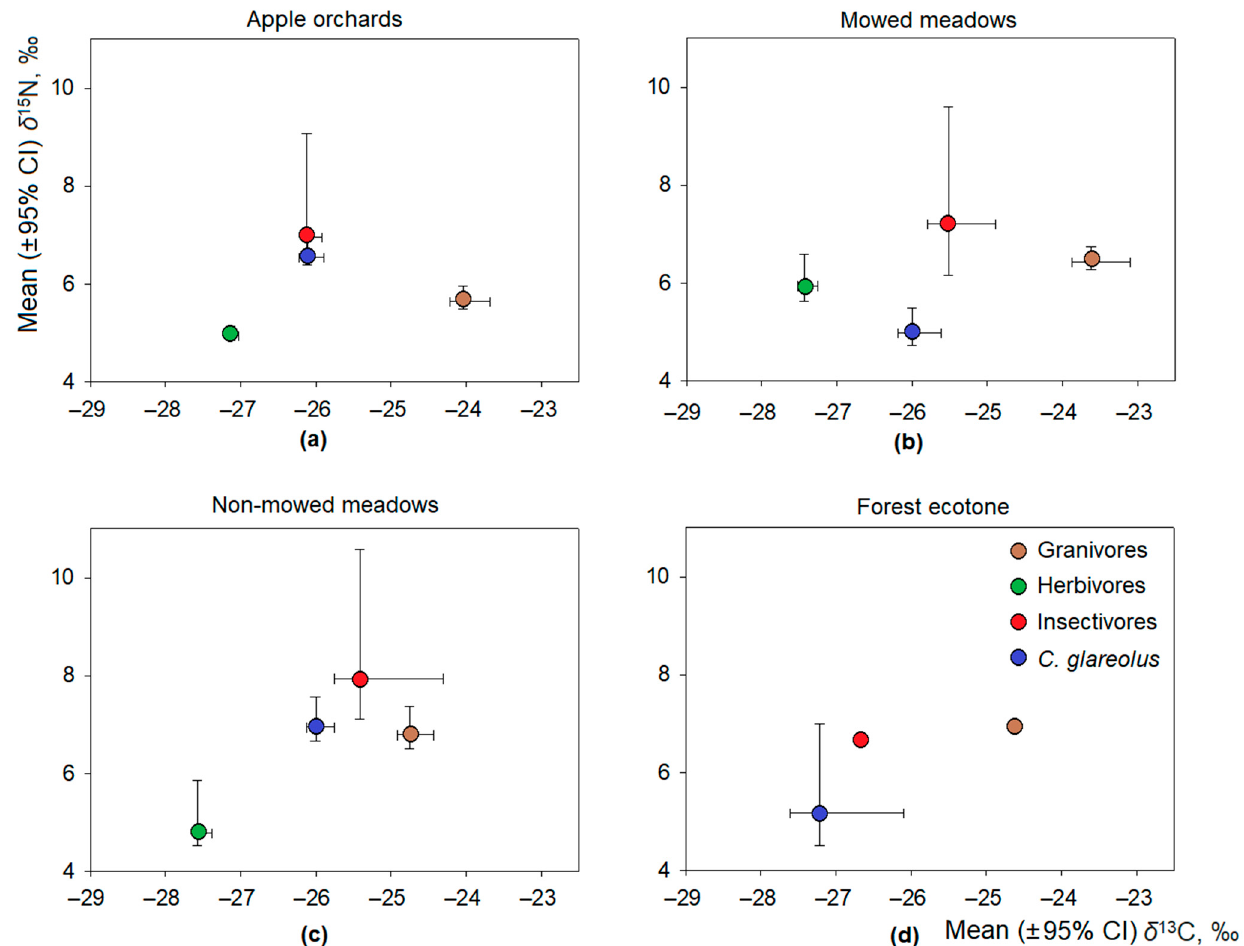
Figure 3. Position of C. glareolus and species of the other trophic groups according to stable isotope ratios: ( a ) in the apple orchards; ( b ) in mowed meadows; ( c ) in non-mowed meadows; and ( d ) in forests. Due to insignificant variation, SE is not visible for some groups. Sample size of herbivores and granivores in the forests was not sufficient.